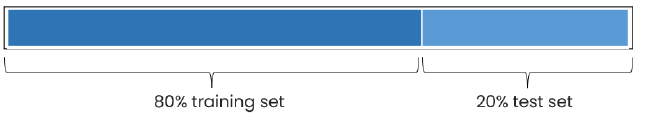
Figure 8. The data set for training and testing.